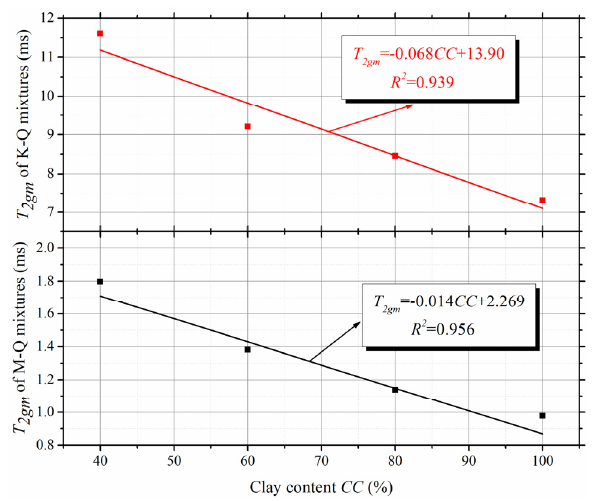
Figure 5. The relationship between T 2 gm and the clay content ( CC ). The lines at the top and bottom